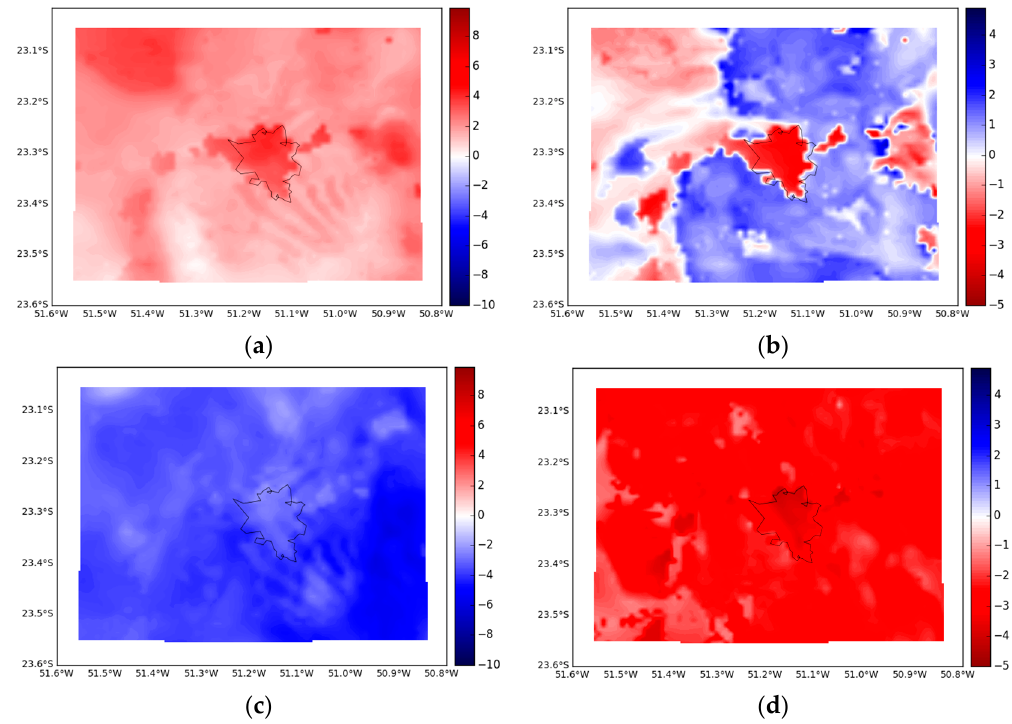
Figure 8. Difference of air temperature at 2 m (in °C) for ( a ) SRESA2 and GFS; ( c ) SRESB1 and GFS; and difference of specific humidity at 2 m (in g/kg) ( b ) SRESA2 and GFS and ( d ) SRESB1 and GFS for 18 Z at 22 July